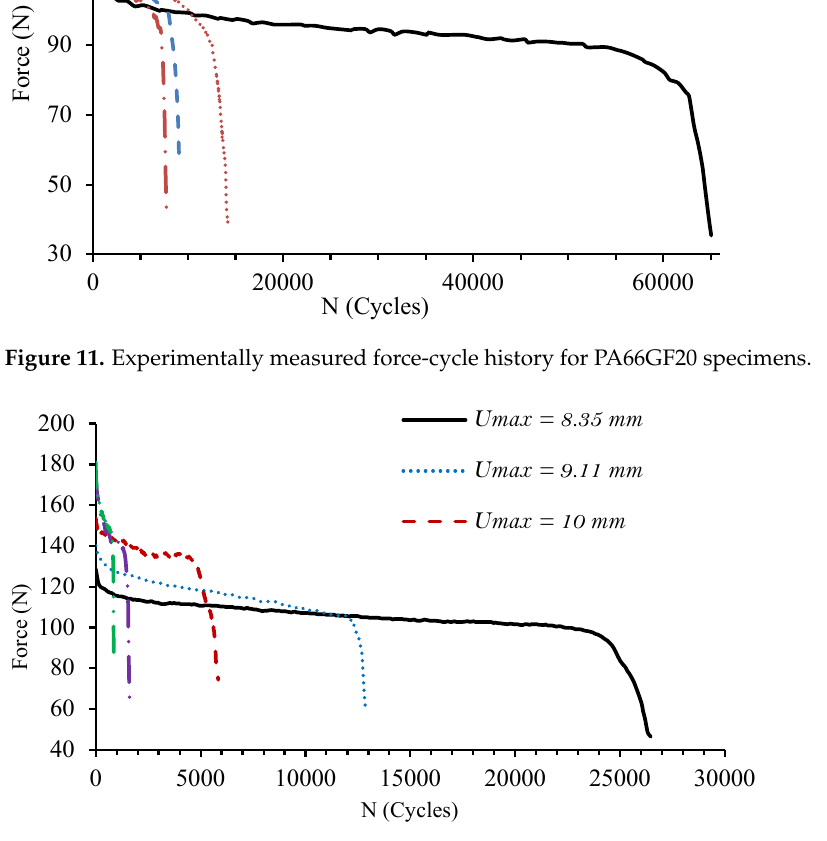
Figure 12. Experimentally measured force-cycle history for PA66GF30 specimens.